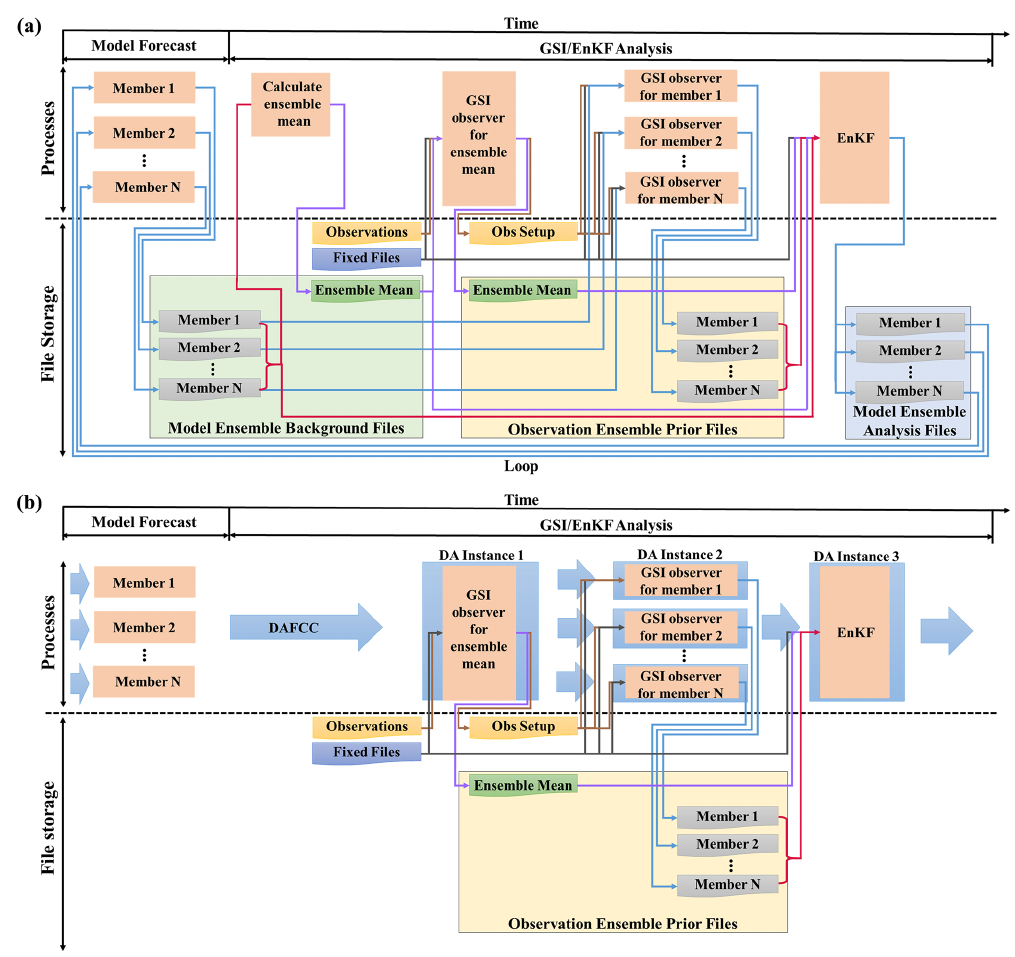
Figure 8. Running processes and data scheduling for (a) original GSI/EnKF used as a pure ensemble DA system and (b) modified GSI/EnKF based on DAFCC1. Orange rectangles in the processes panel indicate different running processes, while thick blue arrows mark data schedul- ing based on DAFCC1. Rectangles of various colors with a curved lower edge in the file storage panel indicate different files, while arrows of different colors indicate the scheduling of corresponding files.